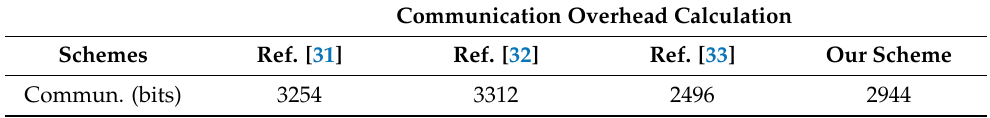
Table 11. Comparison of communication